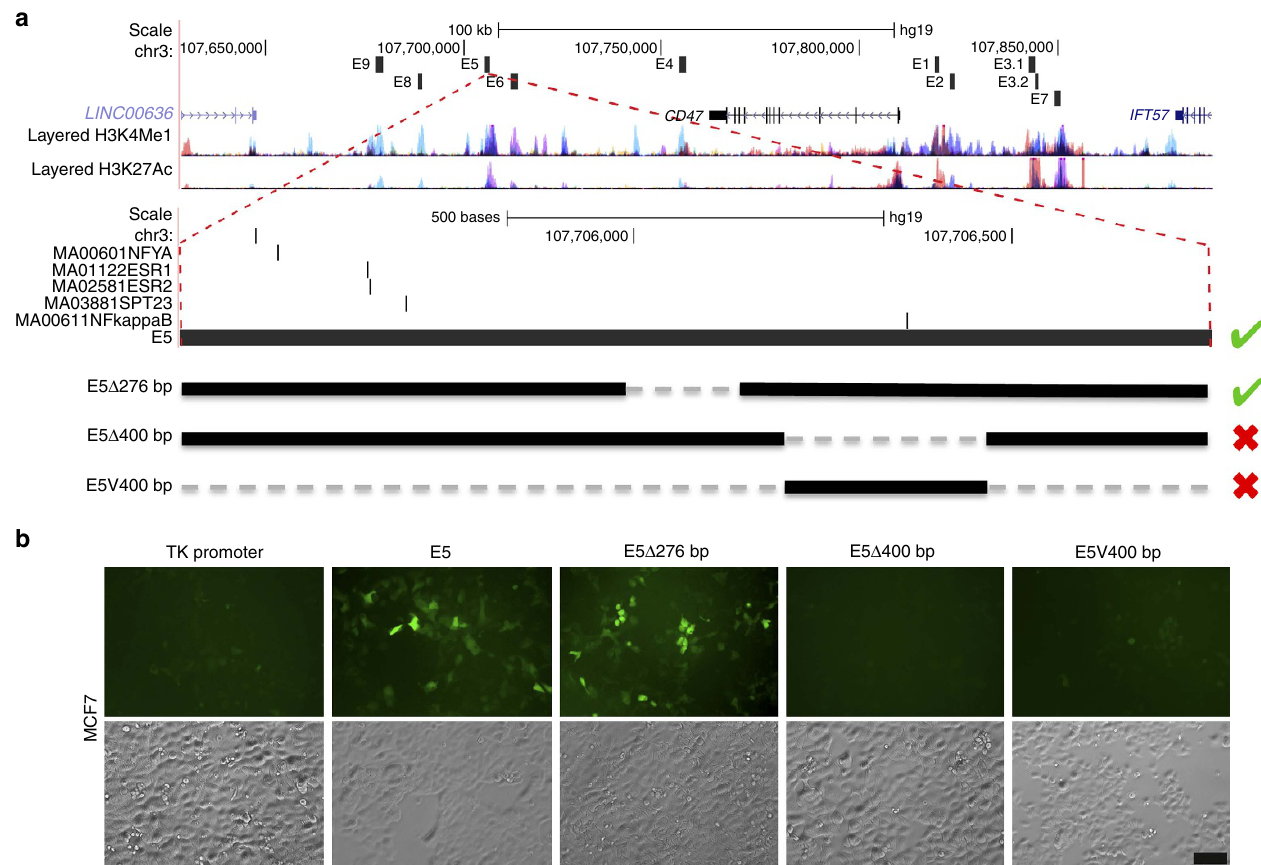
Figure 4 | Regulatory activity of CD47 E5 constituent is abolished by deleting a region containing an NFKB1 binding motif. ( a ) Schematic representation showing the location for NFYA, ESRs, SPT23 and NFKB transcription factor binding sites (black bars) within CD47 SE E5 constituent (black block), predicted by PIQ. H3K4Me1 and H3K27ac ChIP-Seq data publicly available for seven different cell lines (coloured peaks) mark regions of open chromatin. ( b ) Deletion of a fragment containing the NFKB1 binding motif (E5 D 400bp) within CD47 SE E5 constituent abolishes enhancer activity, while a 276bp deletion excluding the NFKB1 motif (E5 D 276bp) did not have any effect on E5 enhancer activity. However, a 400bp fragment containing the NFKB1 binding motif (E5V400bp) alone did not have enhancing activity. Scale bar: 100 m